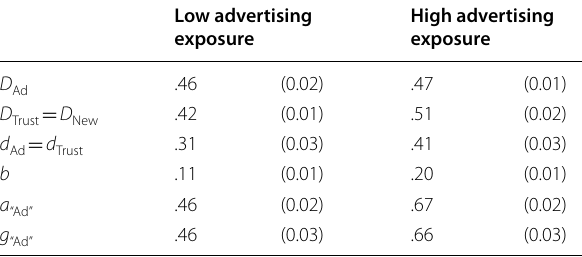
Parameter D ∙ represents the probability of recognizing statements as old or new. Parameter d ∙ represents the conditional probability of remembering the sources of recognized statements. Guessing parameter b represents the probability of guessing that unrecognized statements are old. Parameters a “Ad” and g “Ad” represent the conditional probabilities of guessing that recognized or unrecognized statements were labeled as advertising. Values in parentheses represent standard